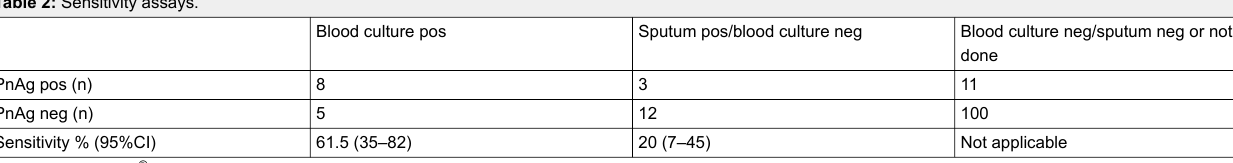
Table 2: Sensitivity assays.